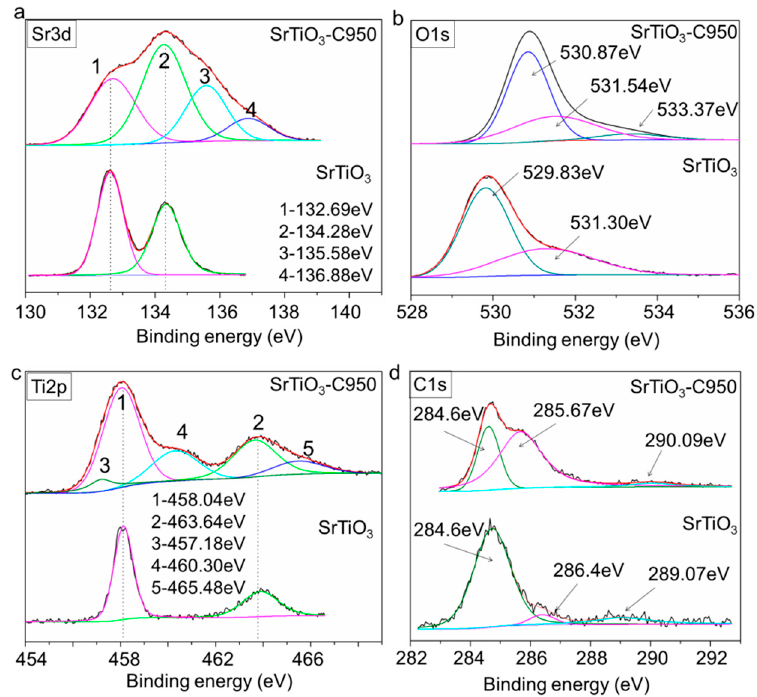
Figure 3. XPS spectra of Sr3d ( a ), O1s ( b ), Ti2p ( c ) and C1s ( d ) of SrTiO 3 and SrTiO 3 -C950.